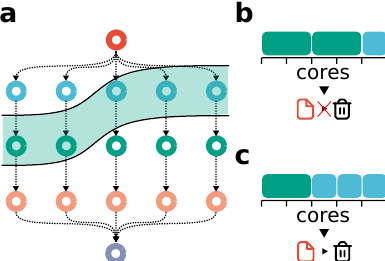
Figure 4. Snakemake scheduling problem. ( a ) Example workflow DAG. The greenish area depicts the jobs that are ready for scheduling (because all input files are present) at a given time during the workflow execution. We assume that the red job at the root generates a temporary file, which may be deleted once all blue jobs are finished. ( b ) Suboptimal scheduling solution: two green jobs are scheduled, such that only one blue job can be scheduled and the temporary file generated by the red job has to remain on disk until all blue jobs are finished in a subsequent scheduling step. ( c ) Optimal scheduling solution: the three blue jobs are scheduled, such that the temporary file generated by the red job can be deleted